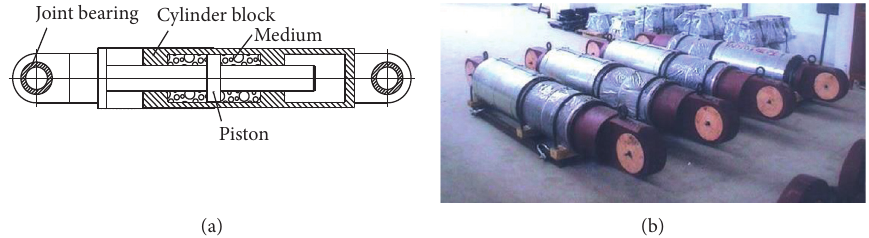
Figure 9: Illustration of VDs. (a) Illustration of the internal structure. (b) Photo of